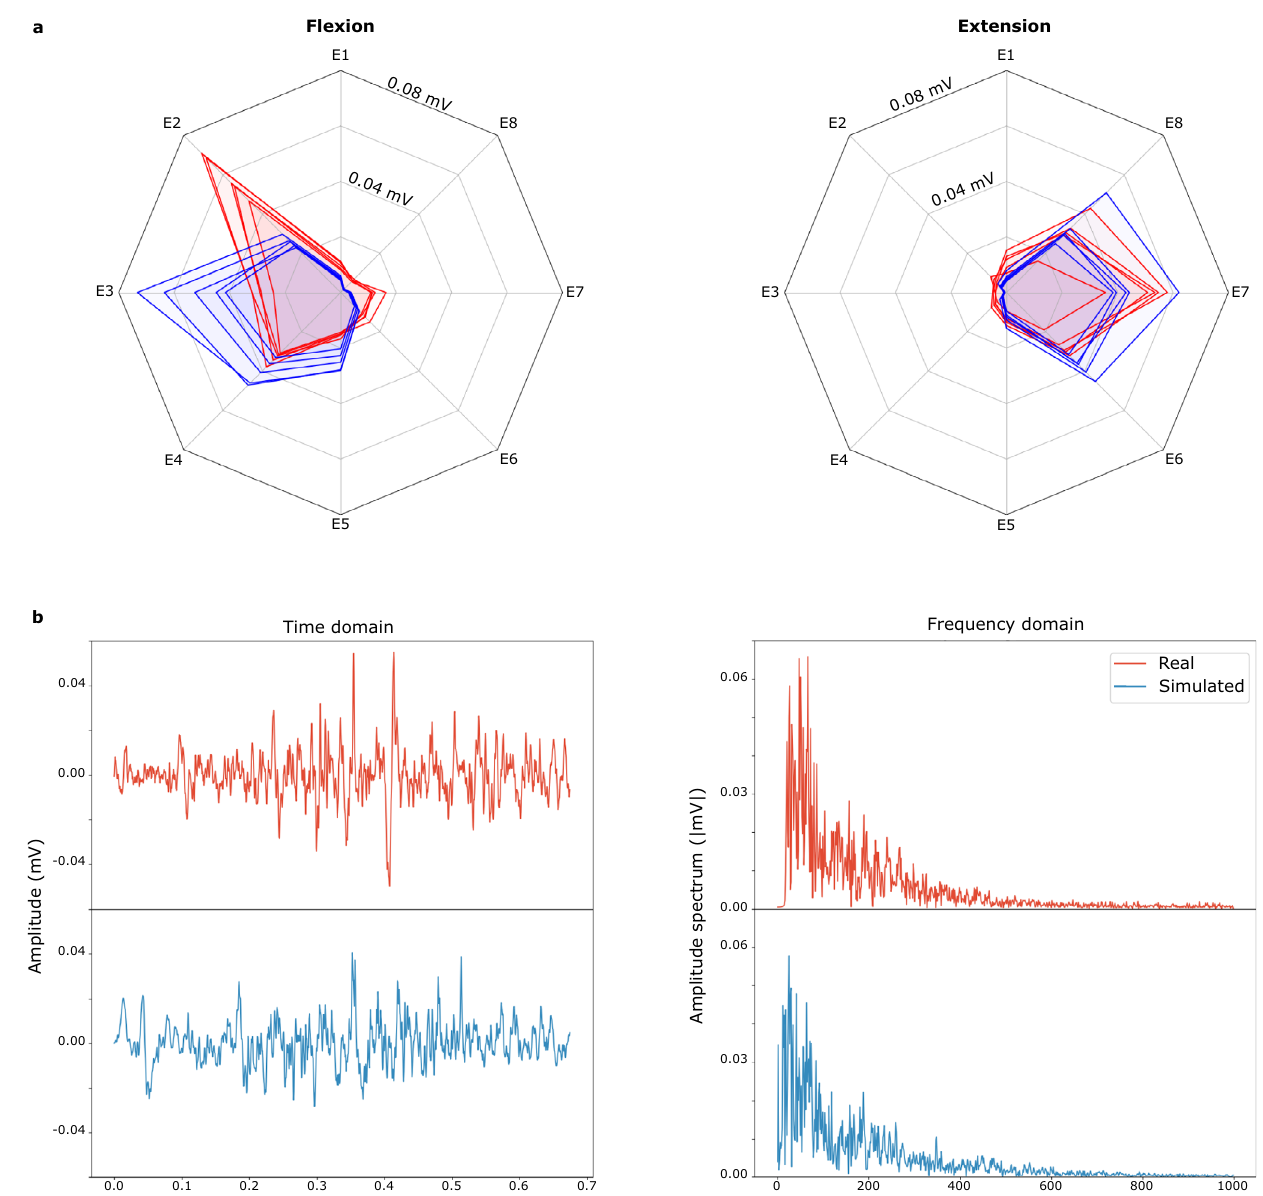
Fig.4|Signalfeaturescomparison.a Comparisonoftherootmeansquarevalues per electrode of experimental (red lines) and simulated (blue lines) surface elec- tromyogram signals corresponding to 5 repetitions of hand fl exion and extension. The electrode con fi guration is the same as shown in Fig. 3. b Comparison of